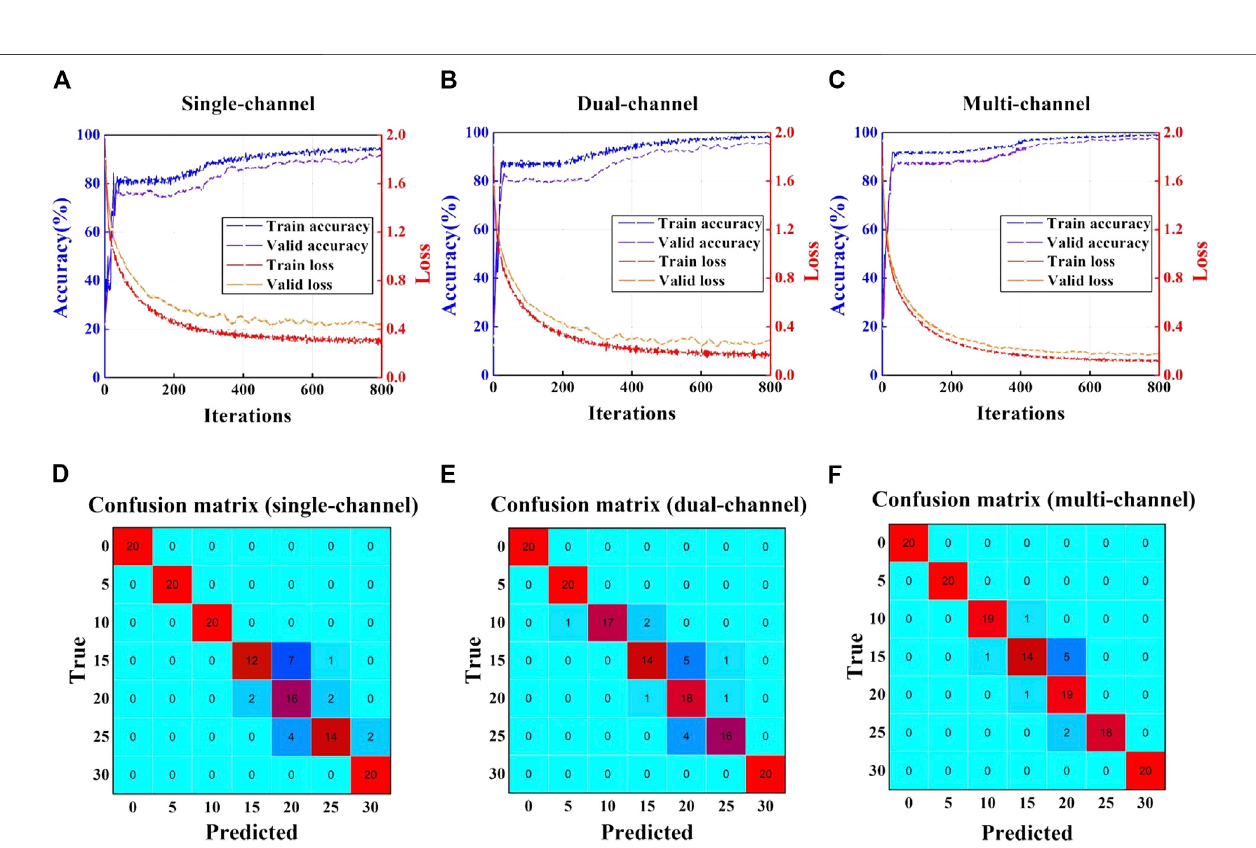
FIGURE 12 | Training/validation process of the 1DCNN and the confusion matrix of the test dataset. (A) Accuracy and loss curves of the single-channel method (PZT2). (B) Accuracy and loss curves of the dual-channel method (PZTs 2 and 4). (C) Accuracy and loss curves of the multichannel method (PZTs 2 – 4). (D) Confusion matrix of the single-channel method (PZT2). (E) Confusion matrix of the dual-channel method (PZTs 2 and 4). (F) Confusion matrix of the multichannel method (PZTs 2 –